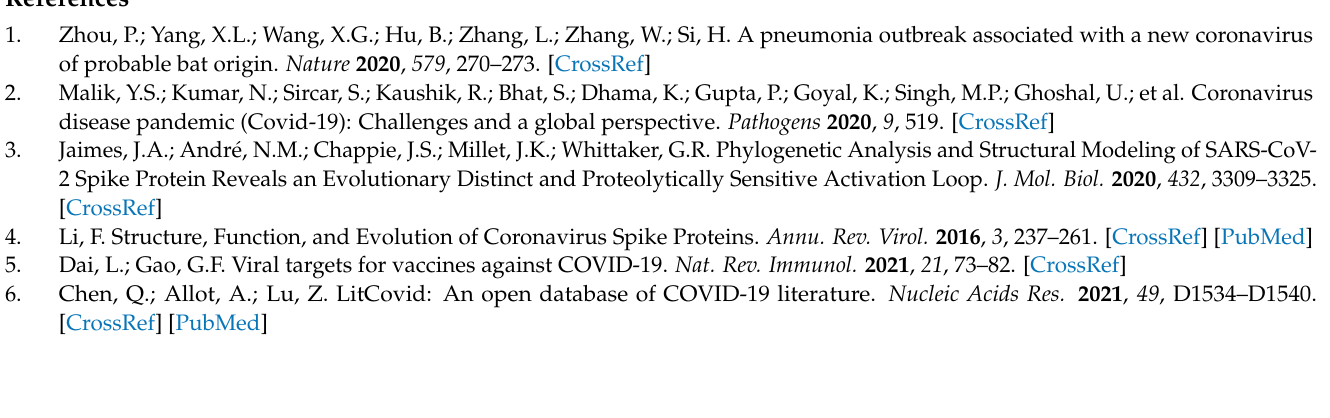
for the POST structure modeling, Figure S4. Functionally important residues in S1, Figure S5. Fusogenic segments mapped on the PRE and POST structures, Figure S6. Free energy for membrane insertion mapped onto the PRE and POST structures, Figure S7. Electrostatic potential on the surface of PRE and POST structures and presumable viral and host membrane positions in SE model., Figure S8. Comparison of the POST structure orientations on the virion., Figure S9. Steps to construct a stalk in PRE state, Figure S10. Hypothetical dislocation of the sTM+HR1 segments, Figure S11. Cryo-EM density used for the constraint in the PRE structure modeling, Figure S12. Optimized POST state structure in the cytoplasmic region, Table S1. Abbreviations used in this study, Table S2. List of segments with previously reported functionality (fusogenic activity) in the literature, Table S3. List of the publicly available spike protein computational models, Table S4. Examples of rotational motion of an S1 trimer, Table S5. List of deposited EMDB density maps and PDB structures, Table S6. Summary of the population in extended (INT/POST) state on the SARS-CoV-2 virion, Table S7. List of putative host factors including receptors and attachment factors, Table S8. List of enzymes reported with the cleavage sites, Table S9. Summary of experimental conditions that are successful in obtaining atomic SARS-CoV-1/2 spike structure in POST state in literature, Table S10. Comparison of viral fusion mechanism between our model and the conventional model mediated by class I fusion protein. The limited items are listed to compare, Table S11. List of software used in this study, Table S12. Resolution and sampling statistics for the original